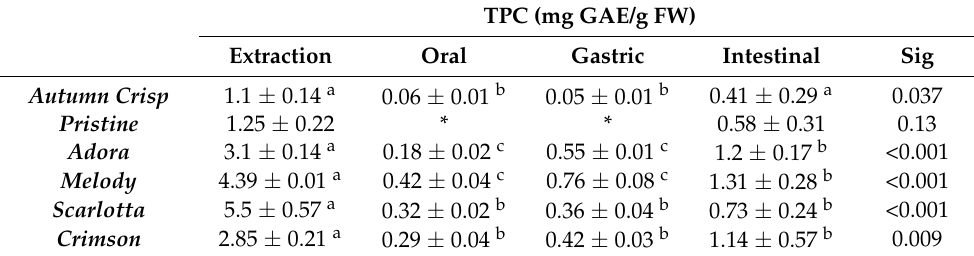
Table 5. Seedless grape polyphenol content at each stage of